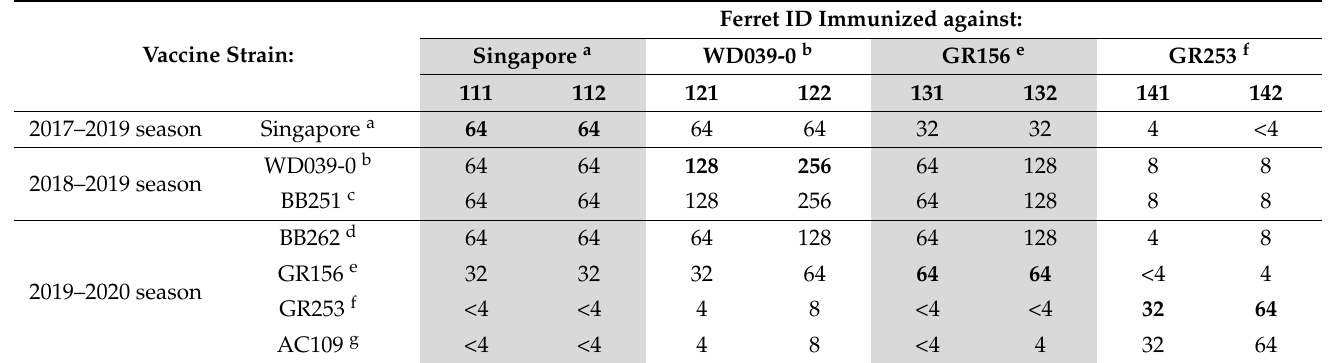
Table 3. Neutralization titers of ferret sera against A(H1N1)pdm09